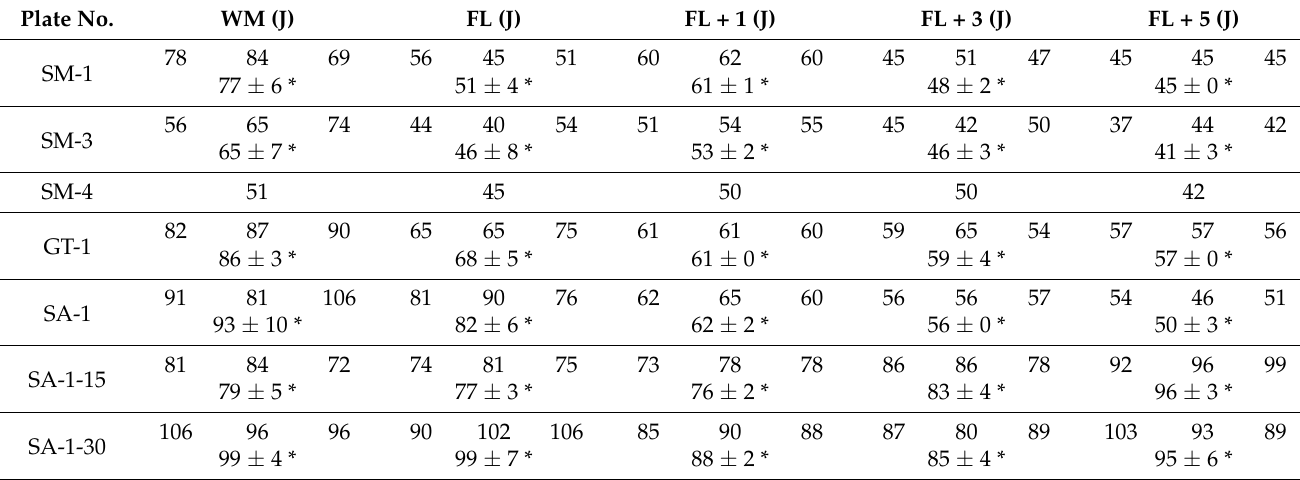
Table 8. Cryogenic V-notch Charpy impact absorbed energy at − 196 ◦